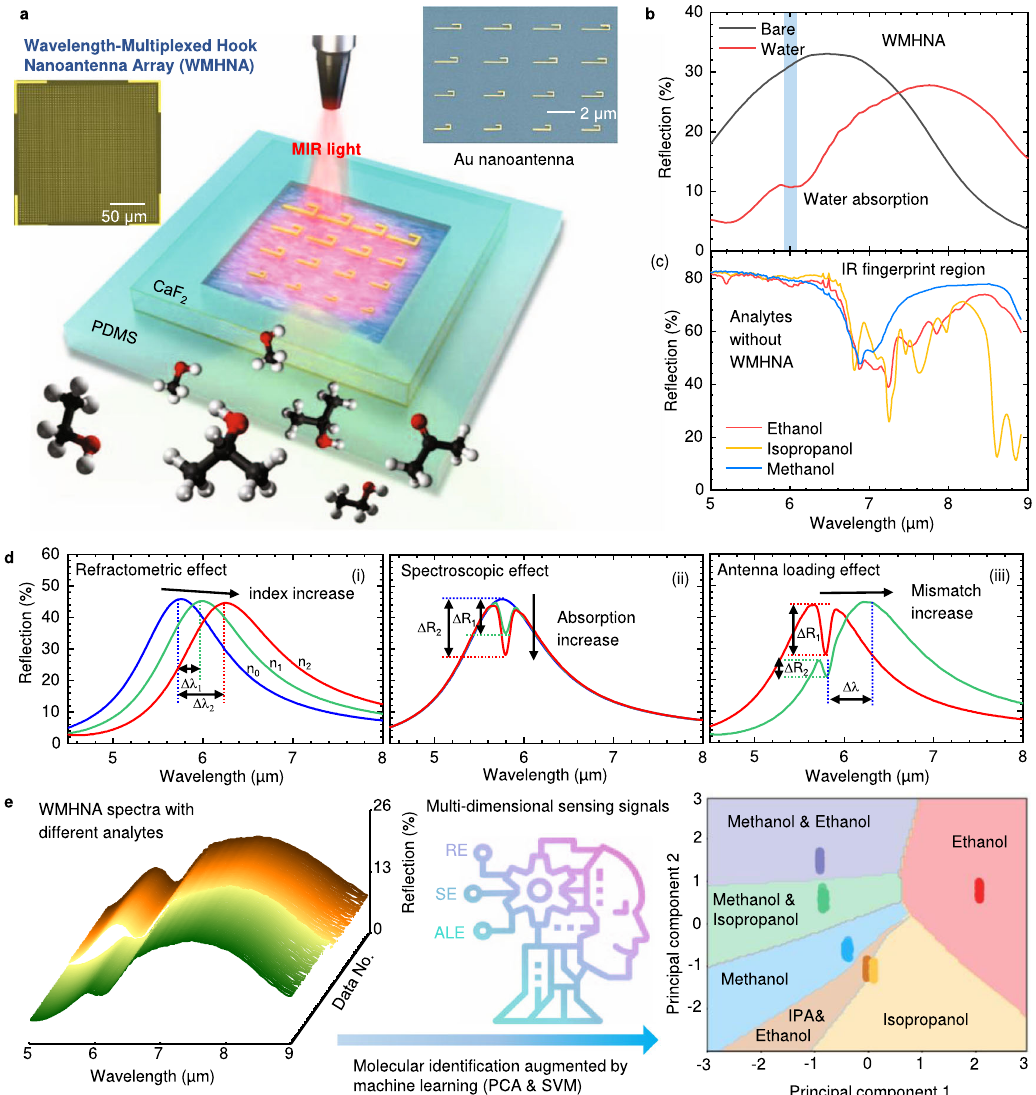
Fig. 1 Working mechanisms of liquid molecular identi fi cation by wavelength-multiplexed hook nanoantenna array (WMHNA). a Schematic drawing of WMHNA on CaF 2 platform with PDMS micro fl uidic chamber. Inset SEM image of one unit cell of WMHNA. b The far- fi eld spectra of WMHNA with and without water measured in the re fl ection mode of the FTIR microscope. c The reference IR absorption spectra of alcoholic liquid (methanol, ethanol, and isopropanol) in the IR fi ngerprint region match with the broadband response of WMHNA. d Illustration of multi-dimensional information in WMHNA system. (i) Refractometric effect (RE): wavelength shift caused by the refractive index of analytes; (ii) Spectroscopic effect (SE): intensity drop due to the absorption of analytes; (iii) Antenna loading effect (ALE): the peak difference brought by the wavelength mismatch between analytes vibration and